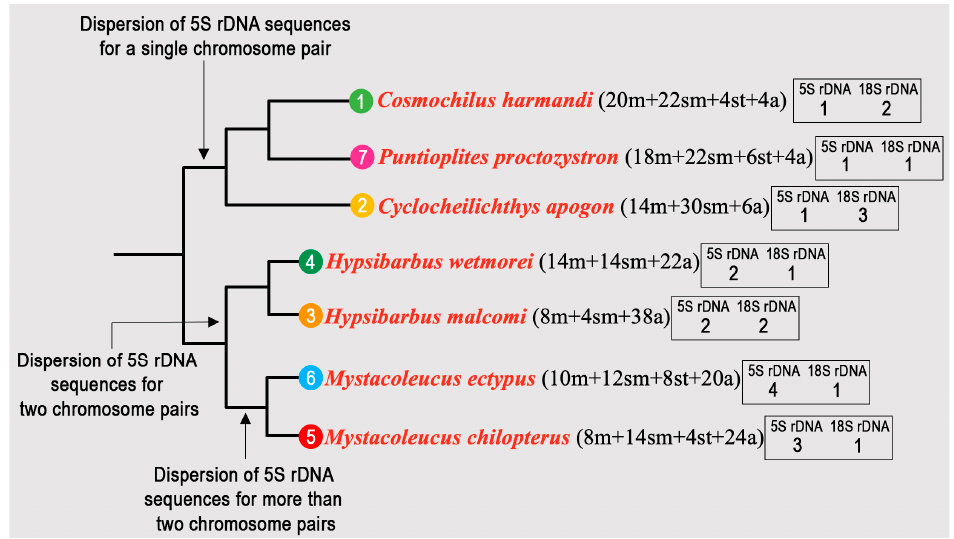
Figure 8. Adapted phylogenetic tree for the tribe Poropuntiinae, based on the molecular-phylogenetic data generated by [2,3], with chromosomal data mapped on it. Superscript numbers correspond, respectively, to the amount of 5S and 18S rDNA loci in their karyotypes. Karyotypes of cyprinoid fi shes usually contain a signi fi cantly higher proportion of biarmed chromosomes than uniarmed ones [5,70]. However, the representatives Hypsibar- bus + Mystacoleucus clade had a signi fi cantly higher number of acrocentric chromosomes than its sister clade, which includes Cyclocheilichthys , Puntioplites , and Cosmochilus (Figure 8). The same was true for other poropuntiin genera such as Balantiocheilos , Barbonymus ,